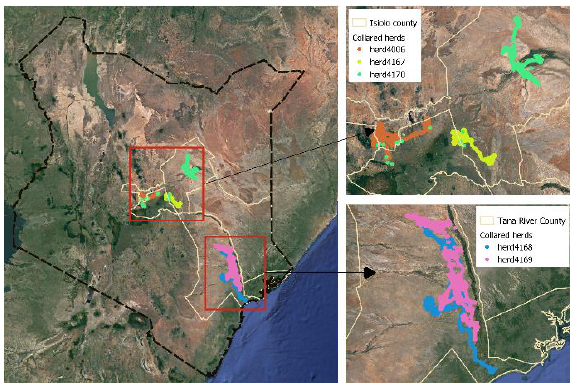
Figure 1 : Study location with telemetry data points of five collared herds in Isiolo and Tana River Counties,